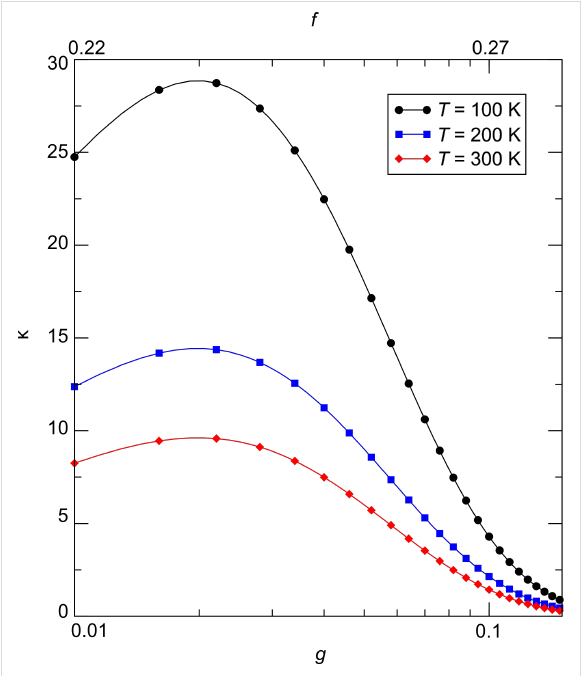
Figure 15: Calculated gauge factor κ as a function of intergrain coupling strength (bottom axis) and metal volume fraction (upper axis) at selected temperatures for the Arrhenius regime at intermediate coupling. Fcc-like packing of Au nanoparticles of 5.5 nm diameter in a dielectric matrix was assumed. The model parameters = 3.29, ε i = 1.02, ε m = − 16400 and = E C were used. For details see